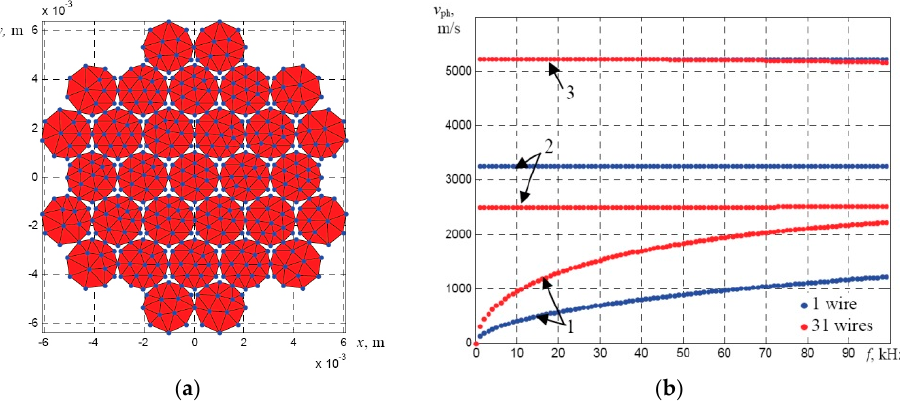
Figure 3. The mesh of the SAFE model of a bundle of solidly connected 31 wires (overall diameter 11.15 mm) ( a ) and comparison of the phase velocity dispersion curves of the guided wave modes ( b ) propagating along: one wire ( blue ), bundle of 31 wires ( red ): 1—flexural-like F (1,1) mode; 2—torsional-like T (0,1) mode; 3—axial-like L (0,1) mode.